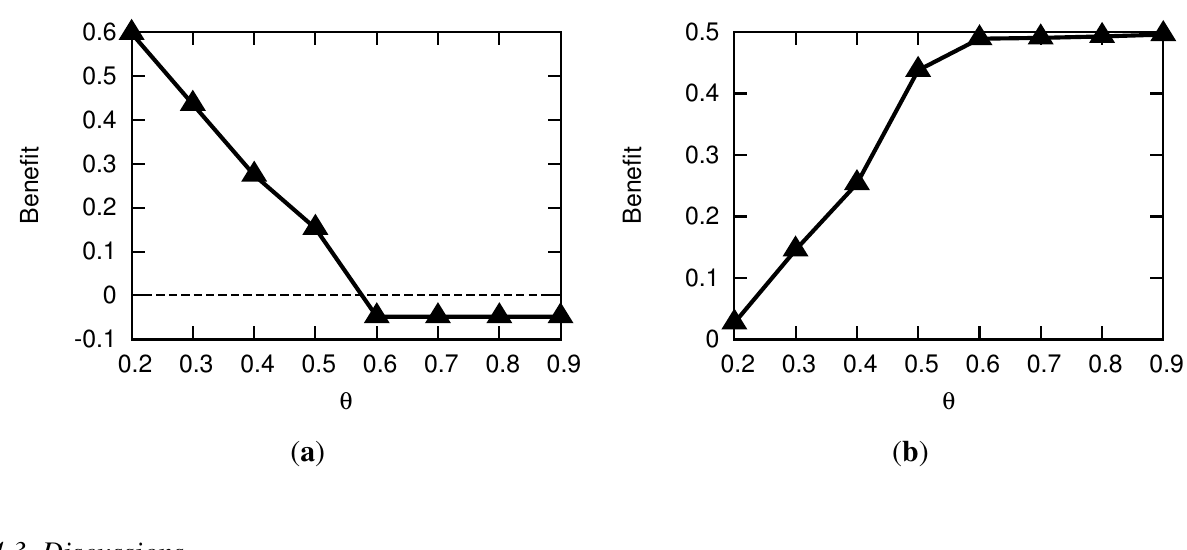
Figure 11. Privacy and energy benefits of AC over Exponential FPR transmission ( E